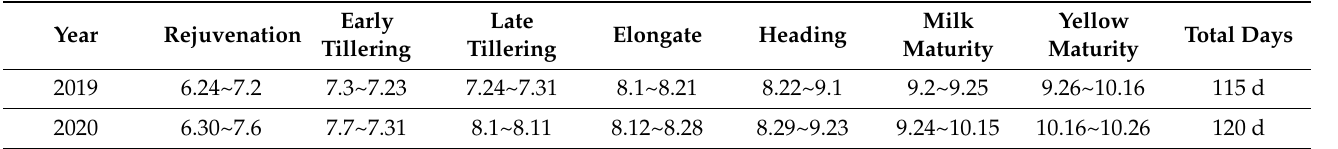
Table 1. Division of growth period of